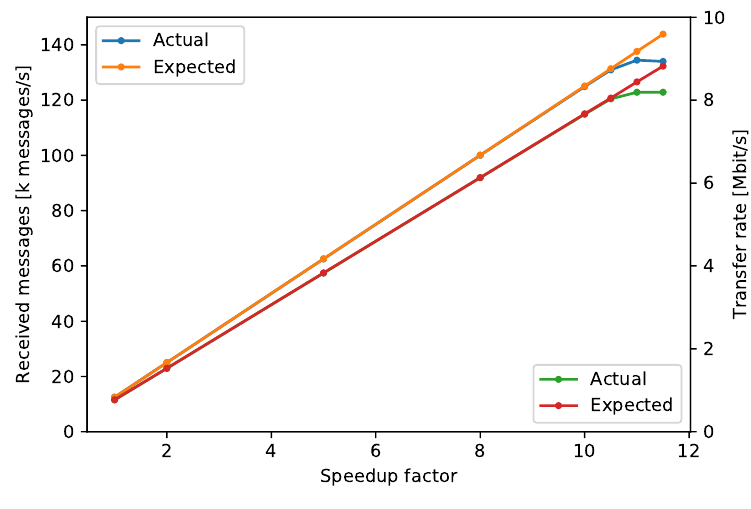
Figure 11. Visualization of Table